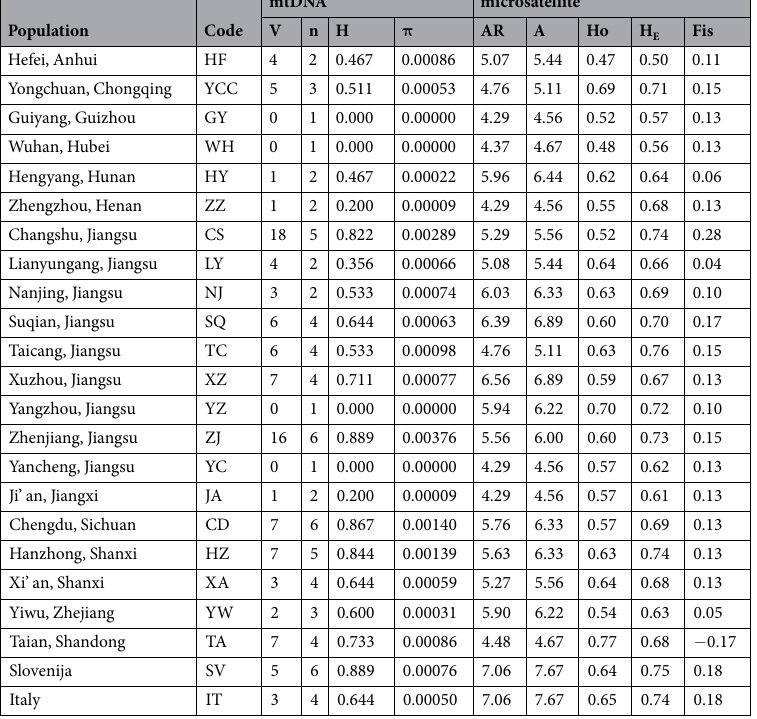
Table 1. Parameters of genetic diversity of 23 Corythucha ciliata populations based on mtDNA and microsatellite loci. V, variation loci per location; n, the number of haplotype per population; H, haplotype diversity; π , nucleotide diversity; N, the number of individuals per population or group; AR, allelic richness; A, number of alleles; Ho, observed heterozygosity; H E expected heterozygosity; Fis, inbreeding